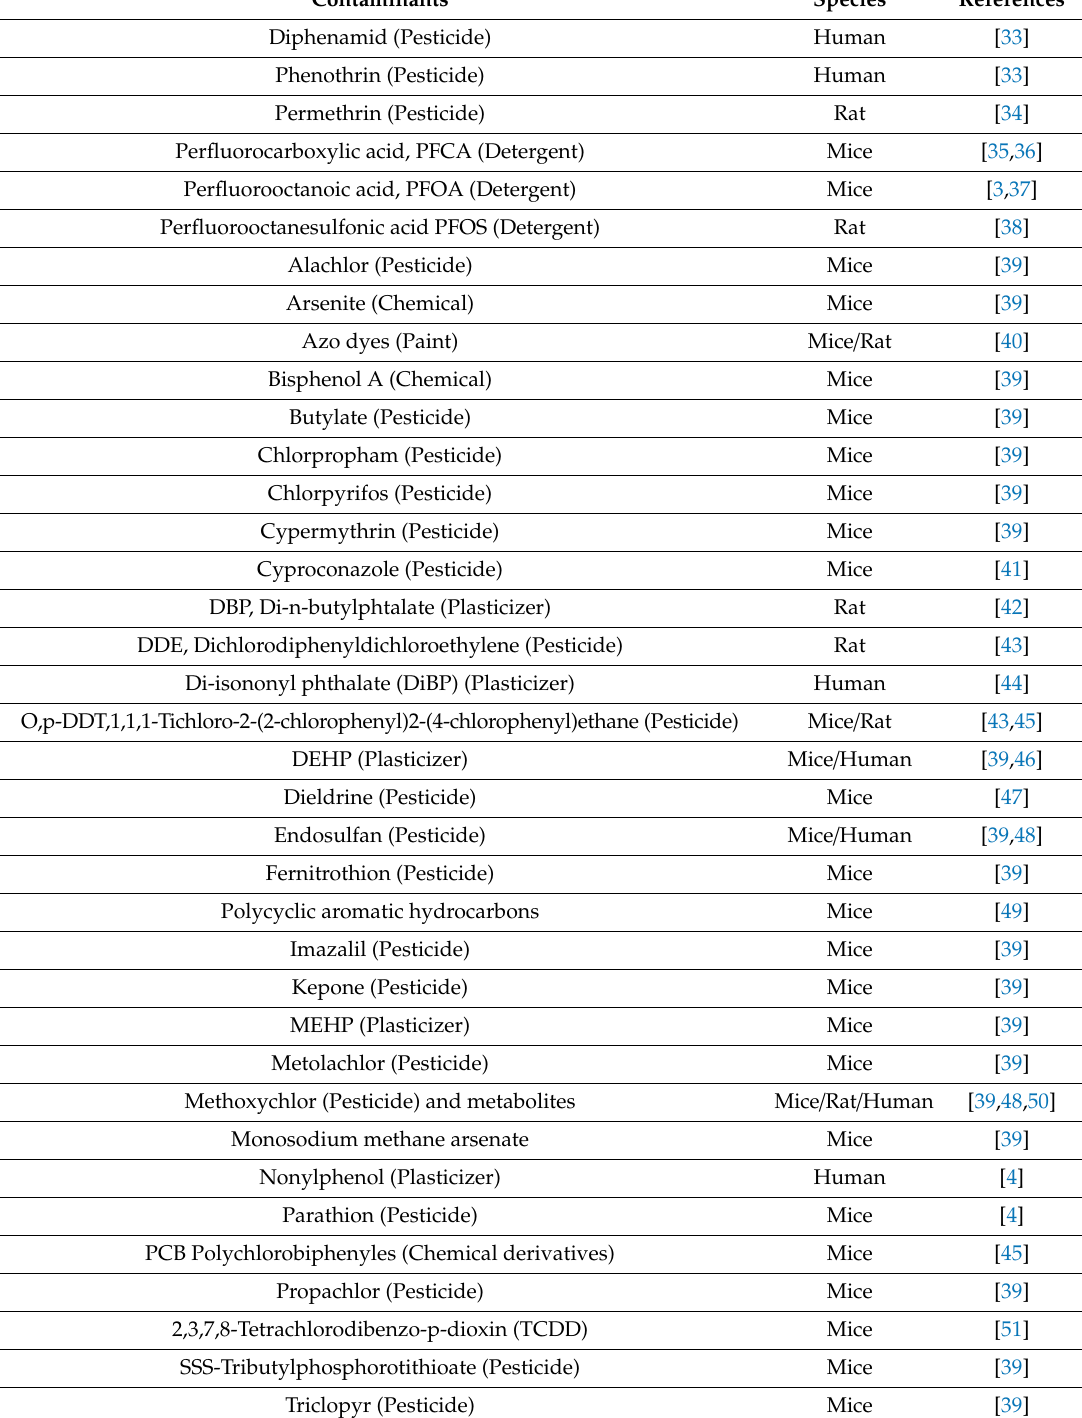
Table 2. Environmental contaminants identified as CAR